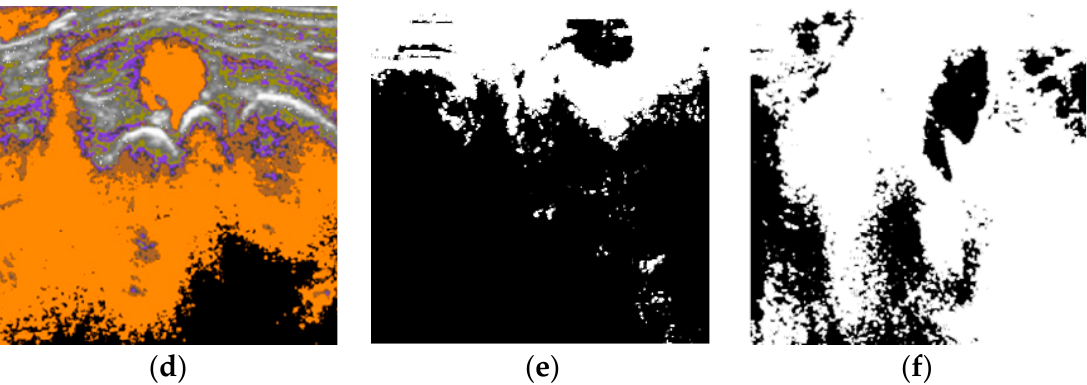
Figure 4. Cases of DBSCAN quantifications. ( a ) Input image 1; ( b ) input image 2; ( c ) input image 3; ( d ) #-of-clusters = 5; ( e ) dark cluster; ( f ) one cluster.